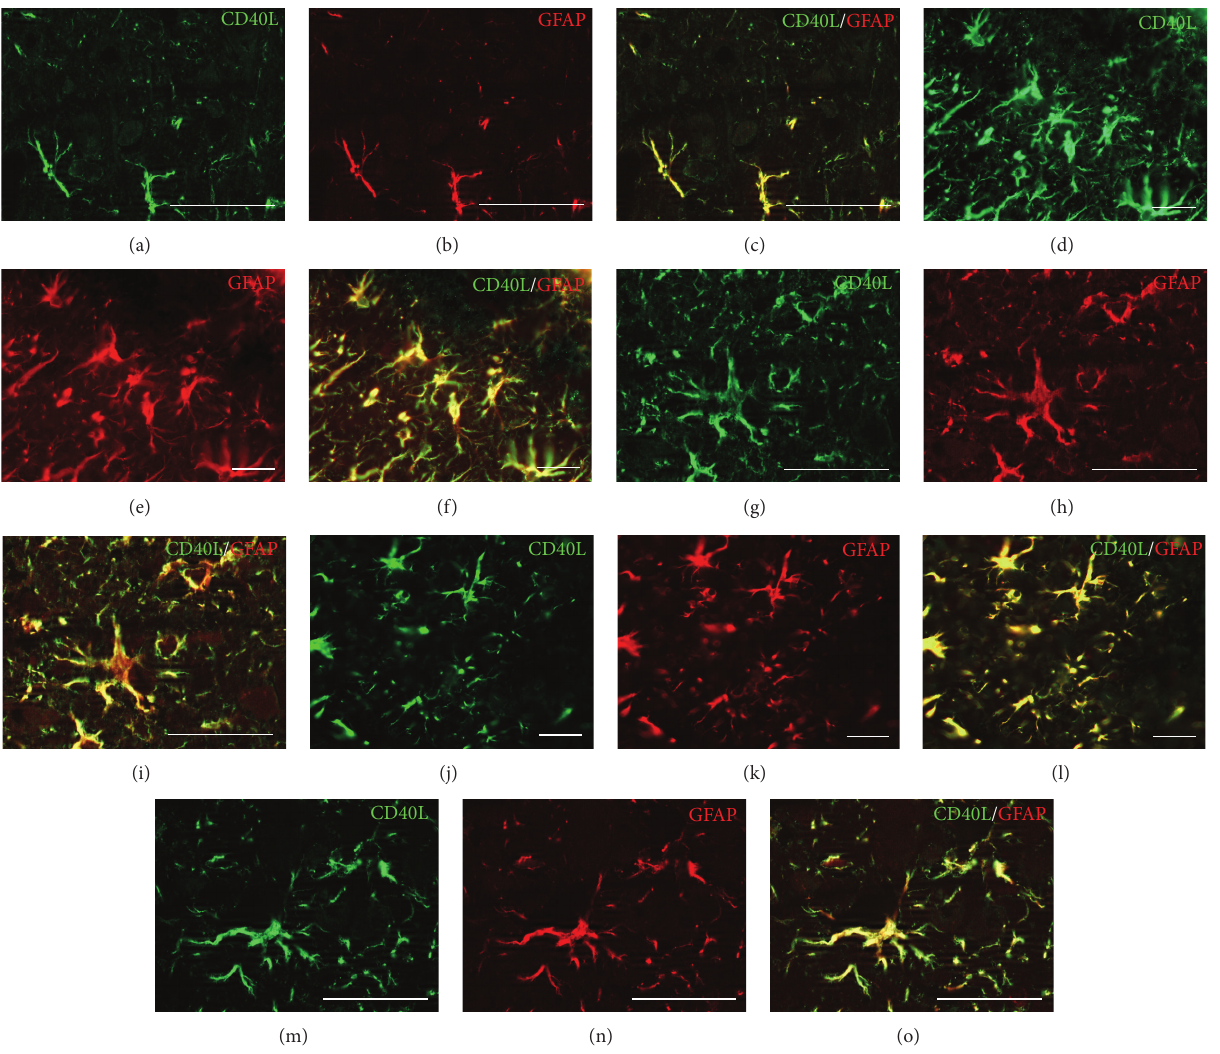
Figure 8: Double-immunofluorescence analysis of CD40L (green) and GFAP (red) colocalization after CSI and HBOT. ((a)–(c)) Sparse CD40L/GFAPpositivefibrousastrocyteswereseeninthecortexofcontrolrats.((d)–(f))StrongCD40LimmunoreactivityoccurredinGFAP + astrocytes that form dense mesh of glial scar in the area adjacent to the lesion site, providing an overlapping signal (yellow fluorescence). ((g)– (i)) CD40L and GFAP signal is abundantly present at protoplasmic astrocyte cell bodies, and thick proximal and distal processes. ((j)–(l)) Repetitive HBOT decreased intensity of CD40L/GFAP immunofluorescence. ((m)–(o)) Reactive phenotype of astrocytes is transformed into more resting form with smaller cell body and long processes resembling morphology of astrocytes from the control group. Scale bar = 50 𝜇